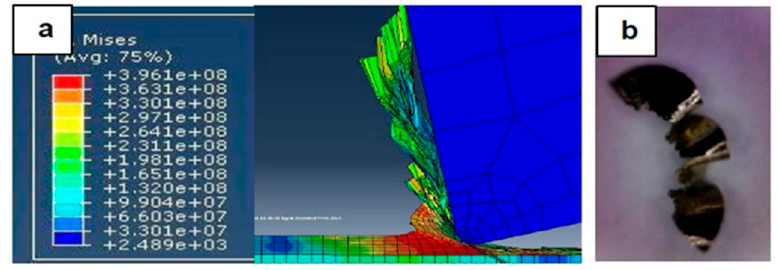
Figure 10. Machining Stainless Steel 316L at feed rate 0.04 mm/rev: ( a ) Chip formation and ( b ) produced chip.